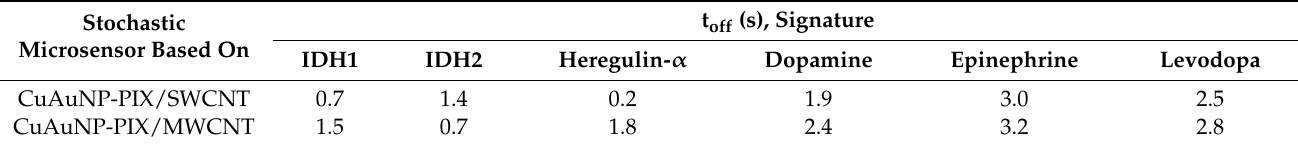
t off (s), Signature